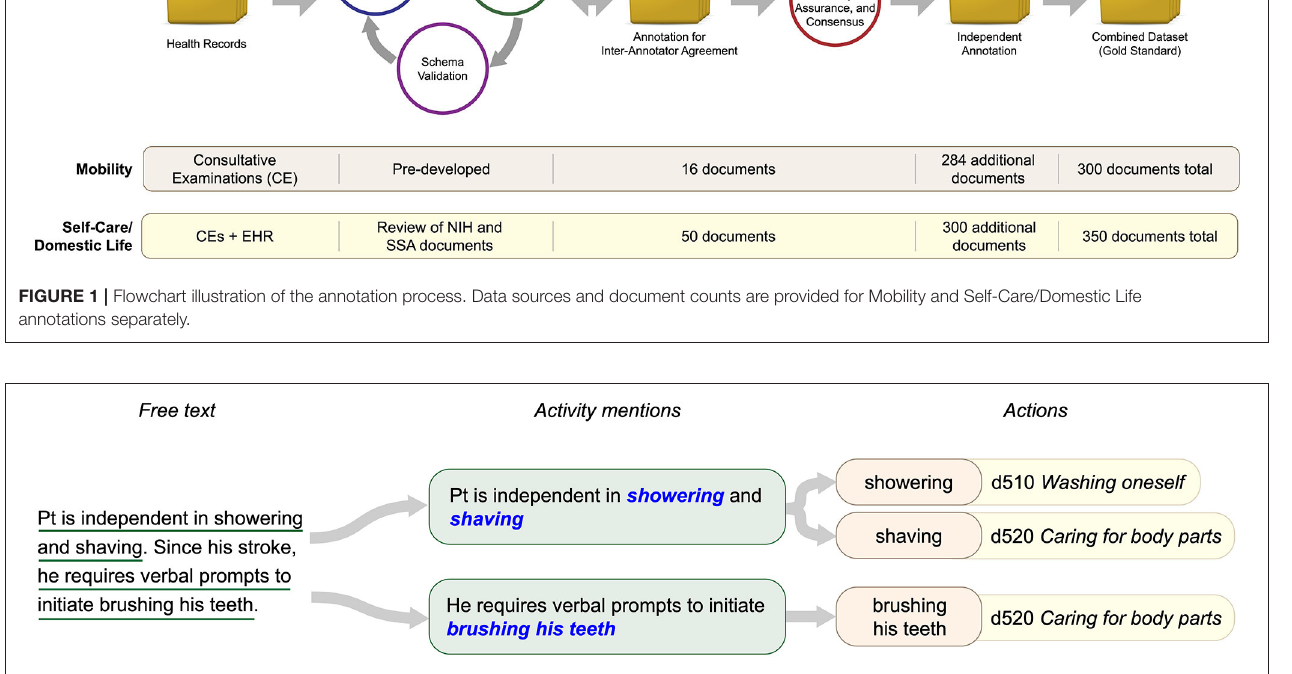
FIGURE 2 | Structure of annotations for functional status information. Free text is annotated to identify activity mentions describing specific observations. Each activity mention may include one or more Action components, which can be mapped to second-level ICF